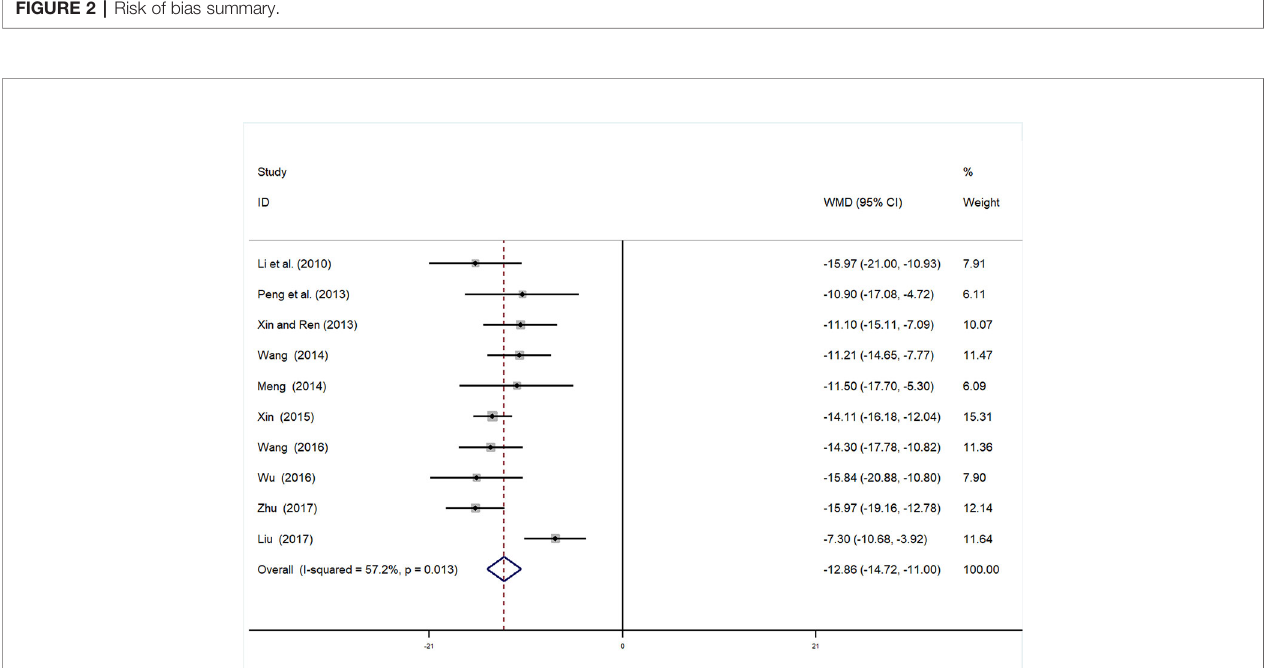
FIGURE 3 | Forrest plot of